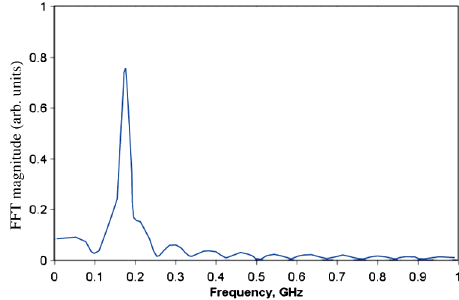
Fig. 12. The peak around 200 MHz is similar to FFT plots of instabilities (Figs. 3.20–3.22) in Ref. [2].